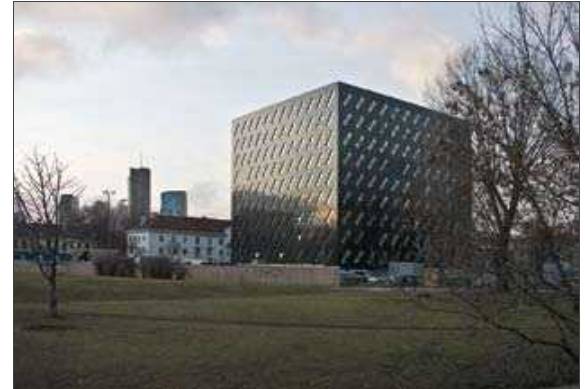
Fig. 11. Prosecutor's Office building (south-east